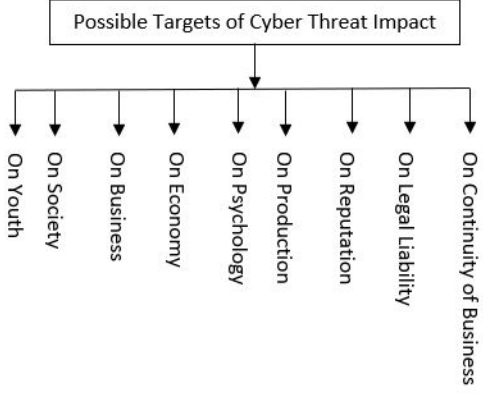
Figure 3. Possible Targets of Cyber Threats